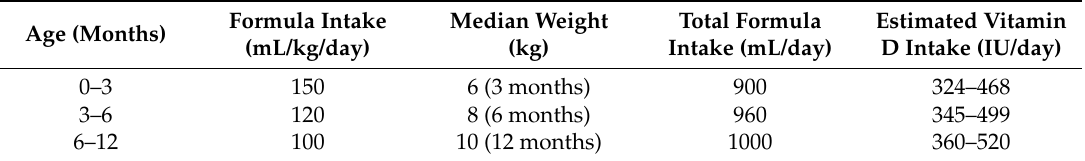
Table 1. Estimates of vitamin D intake in fully formula-fed